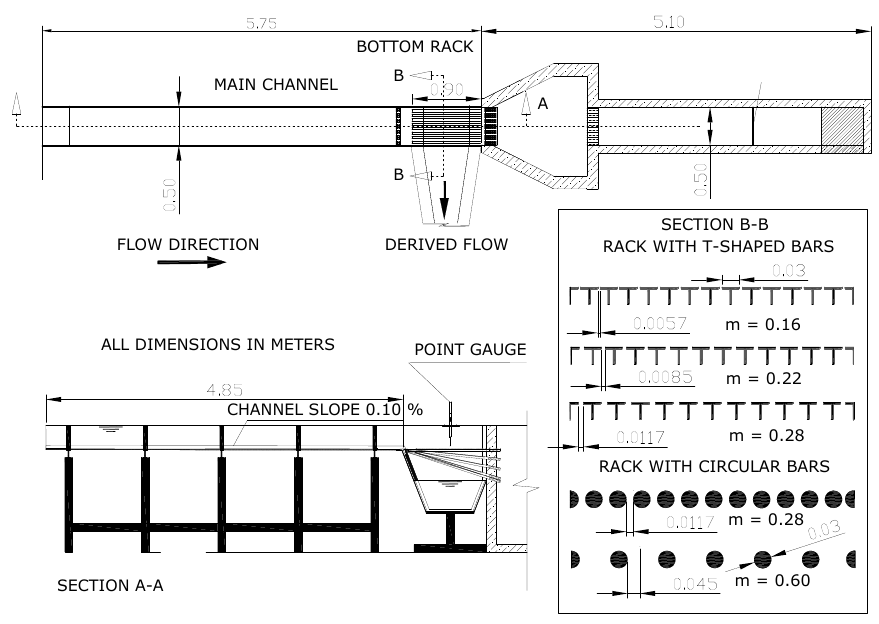
Figure 5. Scheme of the intake system physical device.